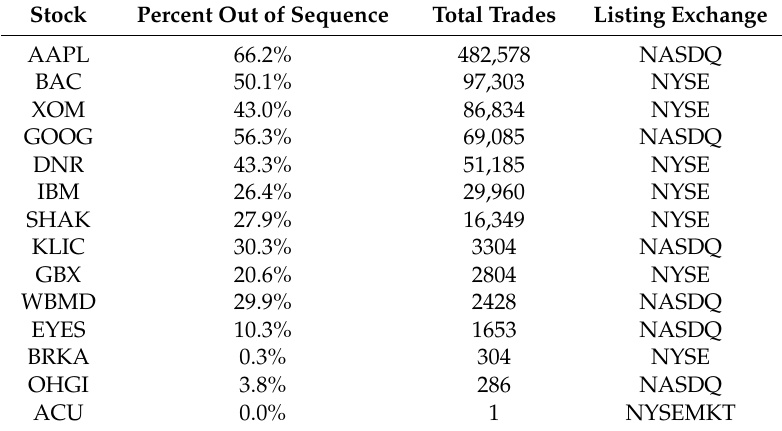
Table 1. Trades out of sequence for selected stocks on 11 August